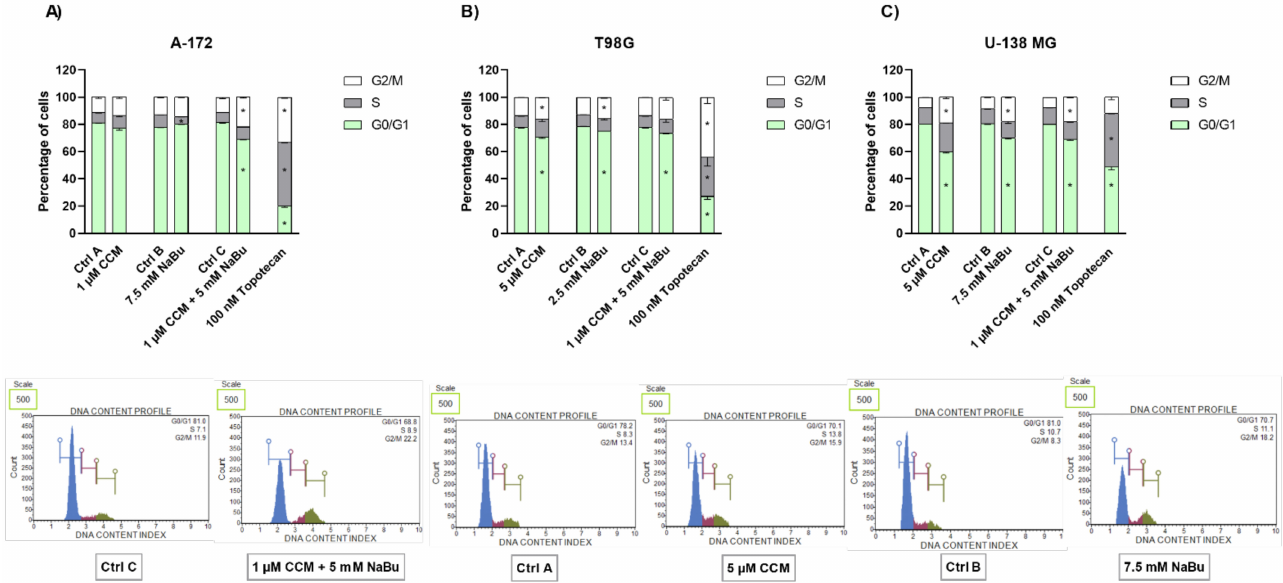
Figure 5. Impact of CCM and NaBu and their combination on cell cycle distribution in A-172 (Panel A ), T98G (Panel B ), and U-138 MG cells (Panel C ). Percentage of cells in G1/G0, S, and G2/M phase was analyzed by flow cytometry after staining with propidium iodide, and RNase A. Topotecan was used as a positive control in this assay. Cells treated with vehicle (DMSO, PBS, or both) are designated as Ctrl A, Ctrl B, and Ctrl C, respectively. Representative histograms are shown below diagrams (Ctrl C and combination treatment of 1 µ M and 5 mM NaBu refer to A-172 cell line, Ctrl A, and 5 µ M CCM refer to T98G cell line, and finally Ctrl B and 7.5 mM NaBu refer to U-138 MG cell line). Values are shown as mean ± SEM calculated from three independent experiments. (*) indicates statistically significant differences from control group for a particular phase, p <